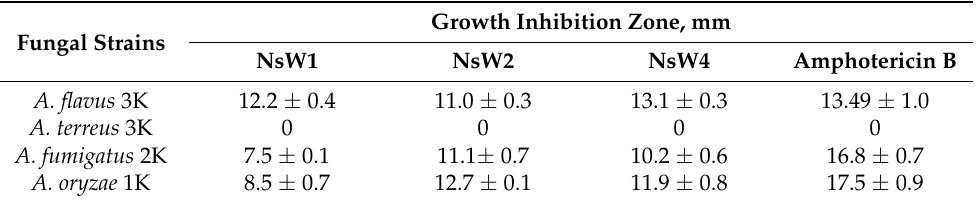
Table 2. The activity of purified N. sativa thionins on Aspergillus strain growth (mm) measured by disc-diffusion assay. Peptide concentration is 0.5 mM (~1 nmol per disc).